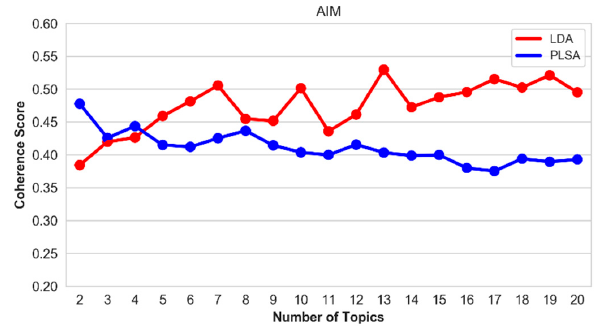
Figure 16. Coherence score of the top-20 topics on the IA hallmark.